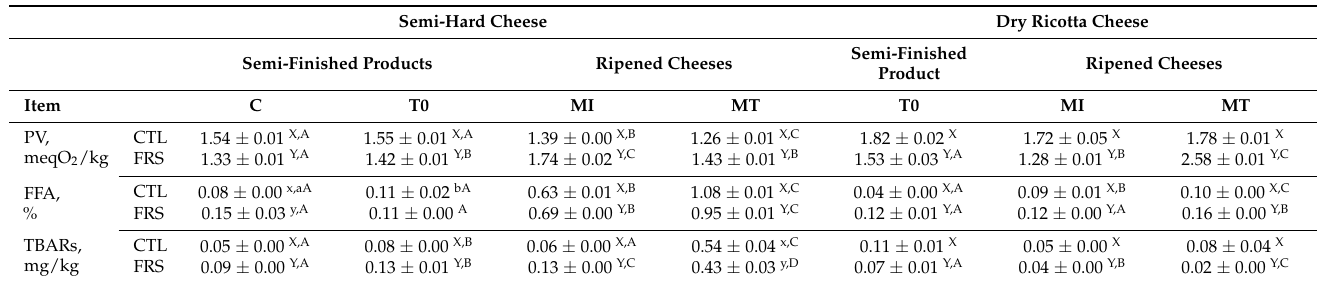
Table 5. Effects of feeding system and ripening time on oxidation index of dry ricotta cheese